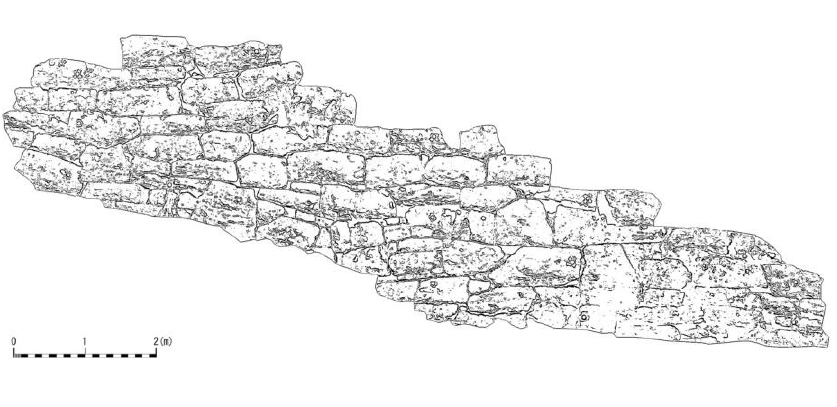
Figure 12. Edge extraction